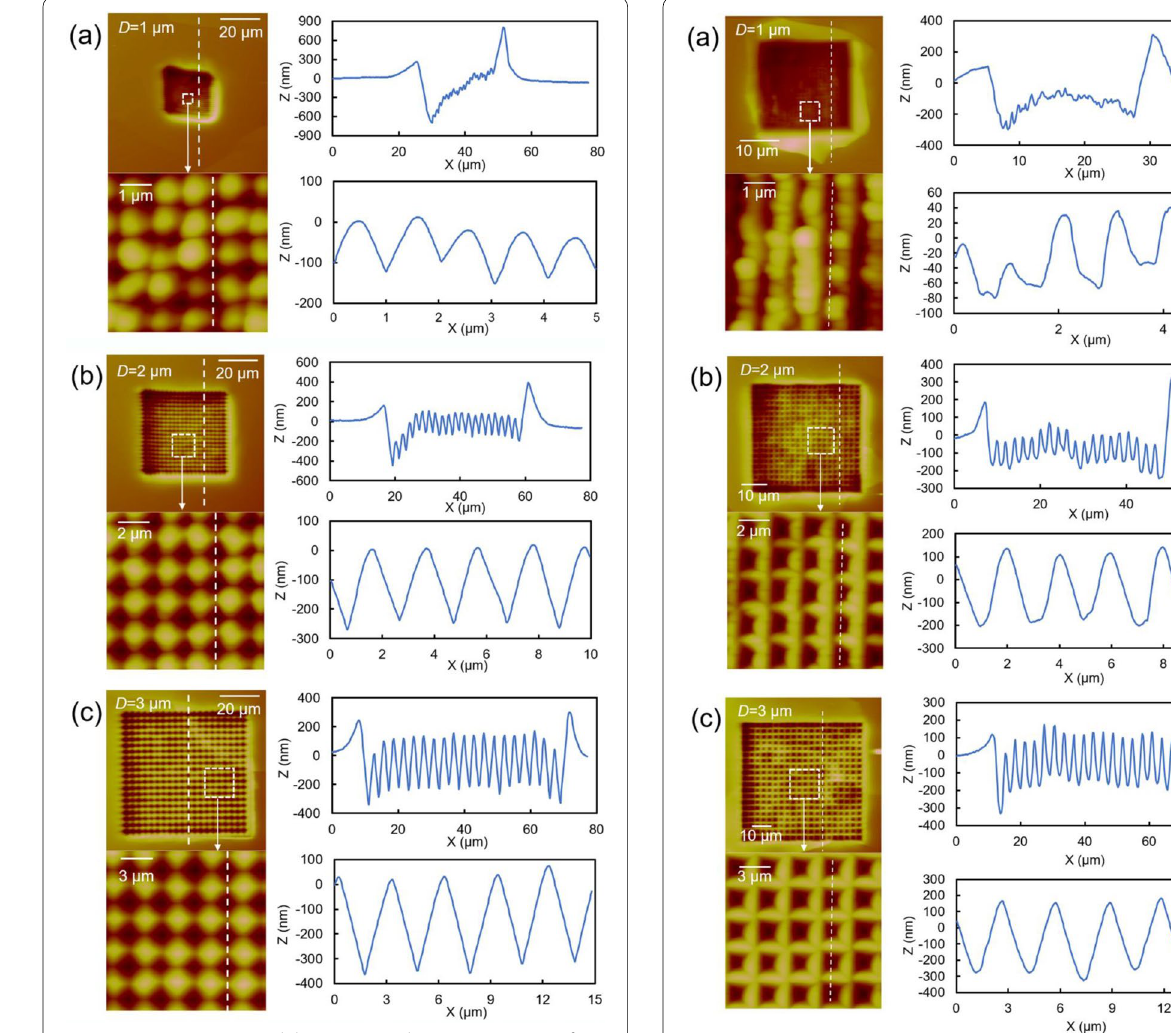
Figure 21 AFM images and the corresponding cross-sections of the experimental results for the 20 20 indentation arrays with the × rotation angle of 0° and the spacings of a 1 μm, b 2 μm and c 3 μm